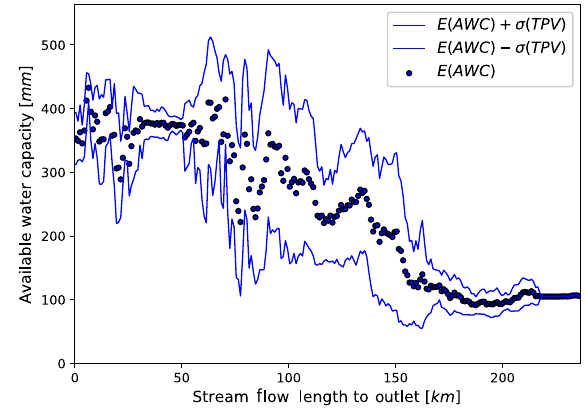
Figure 5. Distance-factor function of AWC in the Mulde